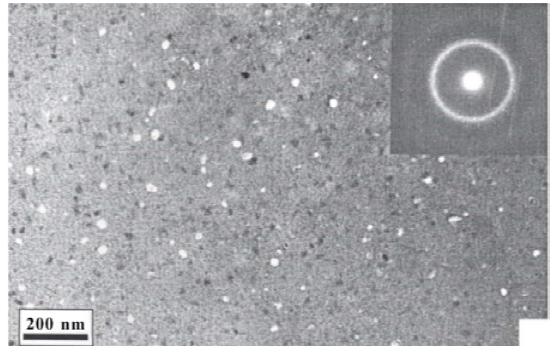
Fe Co Si B 44 29 15 2 10